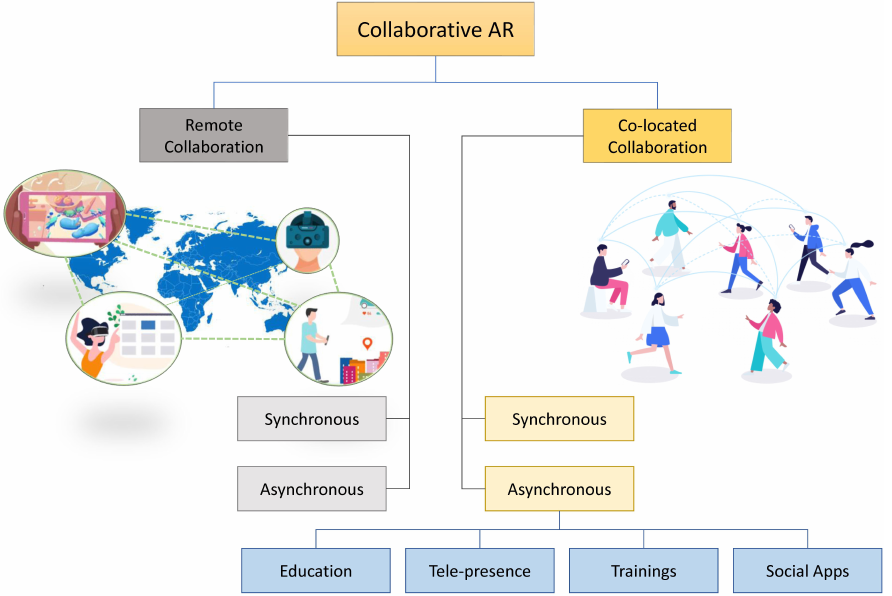
Figure 10. Collaborative augmented reality research